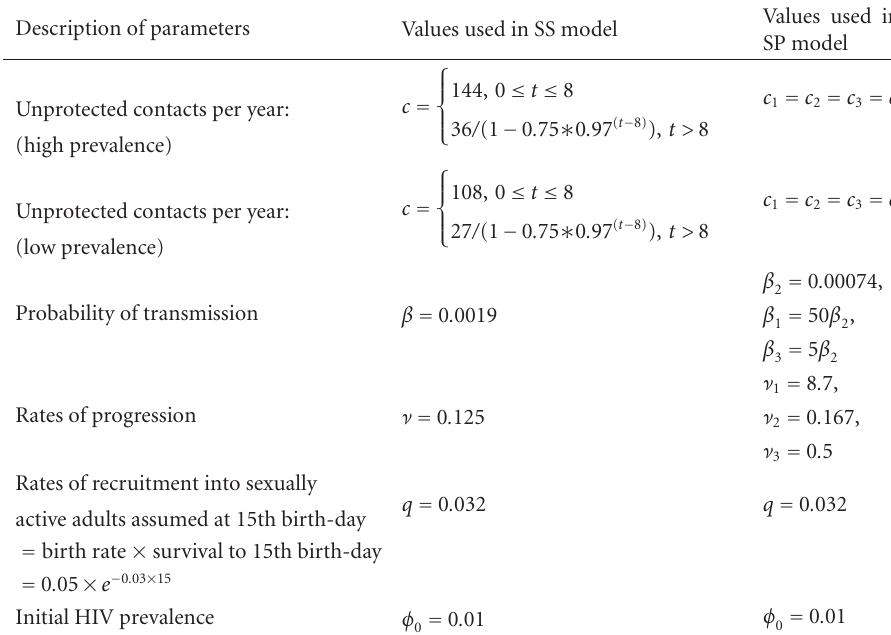
Table 2 . 1 . Table of parameter values used for Figures 2.1 and 2.2. Description of